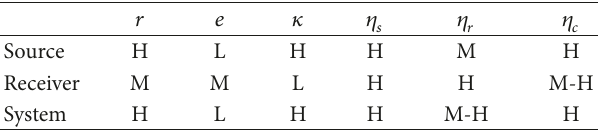
Table 2: Damping design parameters for low vibration level.